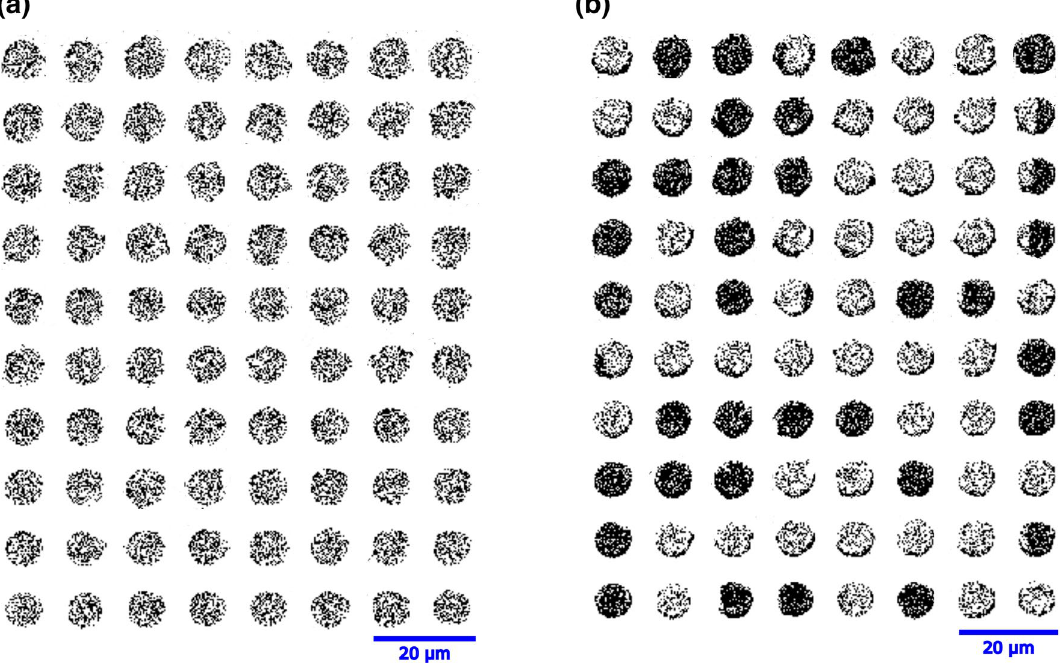
Figure 2. MOKE imaging of the microdisks on the PMN-30PT substrate under the magnetic fields ( a ) 0 mT, ( b ) 37.8 mT. The light and dark contrast corresponds to the magnetization pointing up and down with respect to the substrate